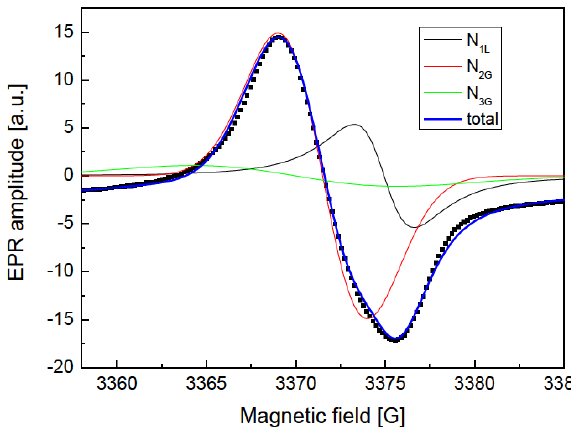
Figure 19: Decomposition of the N component in EPR spectrum of B-400 sample registered at T = 290 K on three subcomponents (one Lorentzian and two Gaussian). Experimental spectrum is presented by dots, the sum of three subcomponents by continuous blue